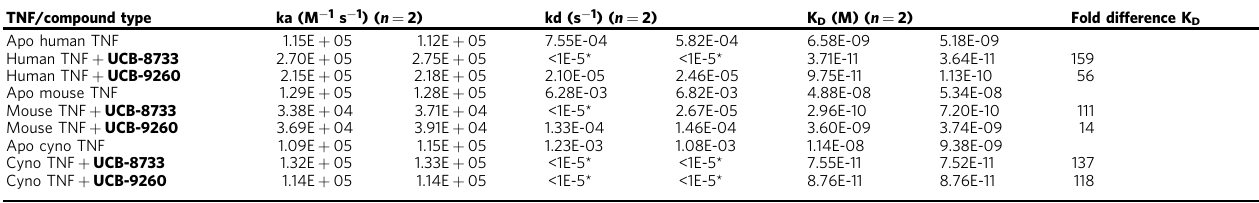
Table 1 CA1974 Surface plasmon resonance binding